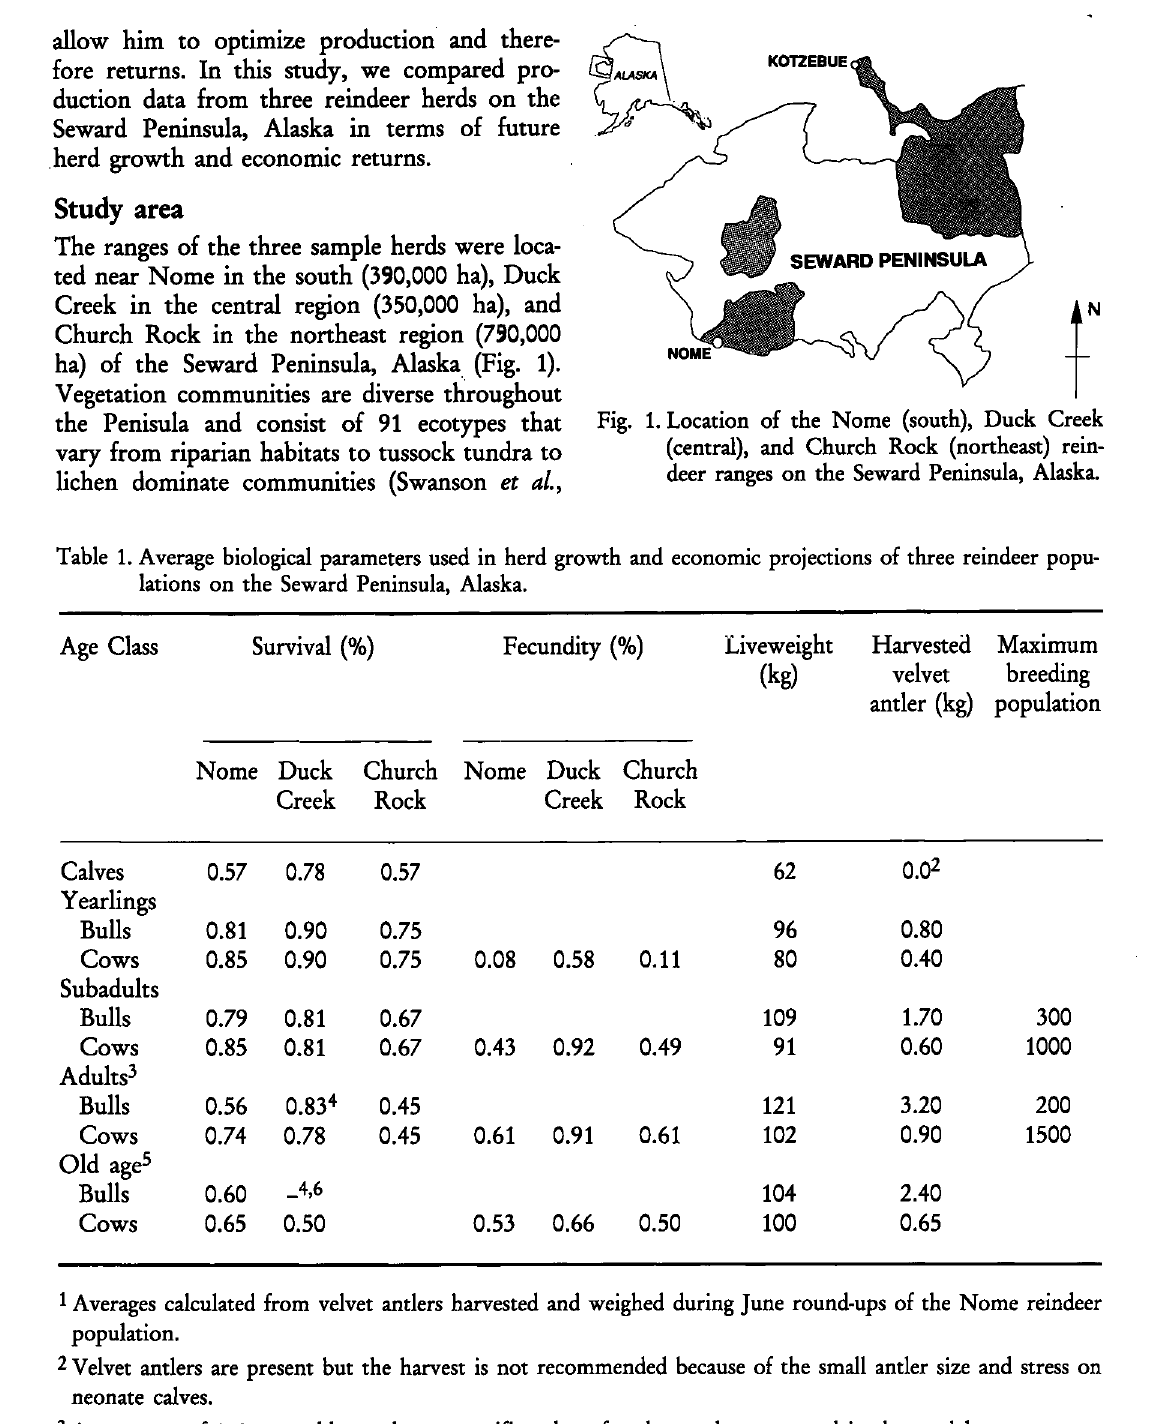
Table 1. Average biological parameters used in herd growth and economic projections of three reindeer popu lations on the Seward Peninsula,